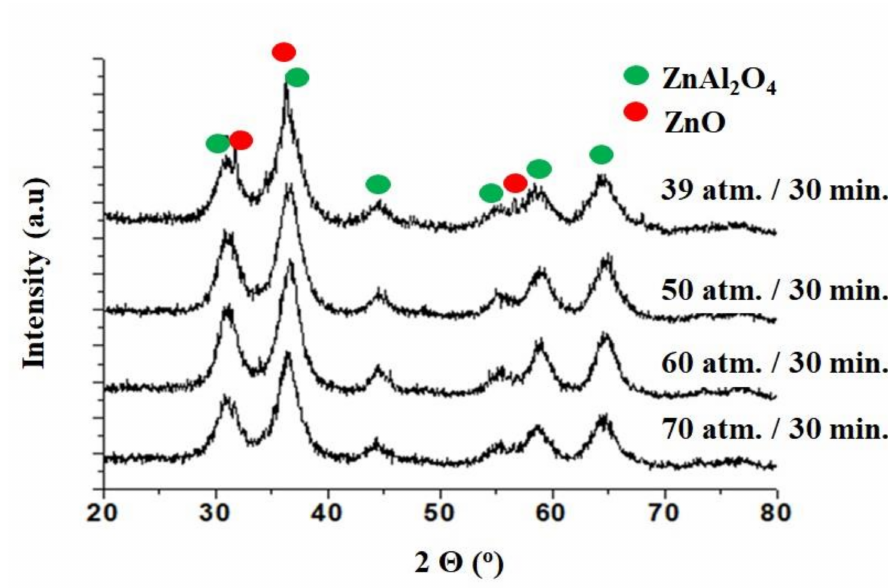
Figure 2. XRD analysis of zinc-aluminum spinel under different pressures.